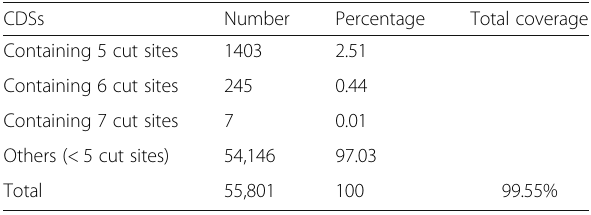
Table 1 The cloning compatibility of the synthesized MCS for